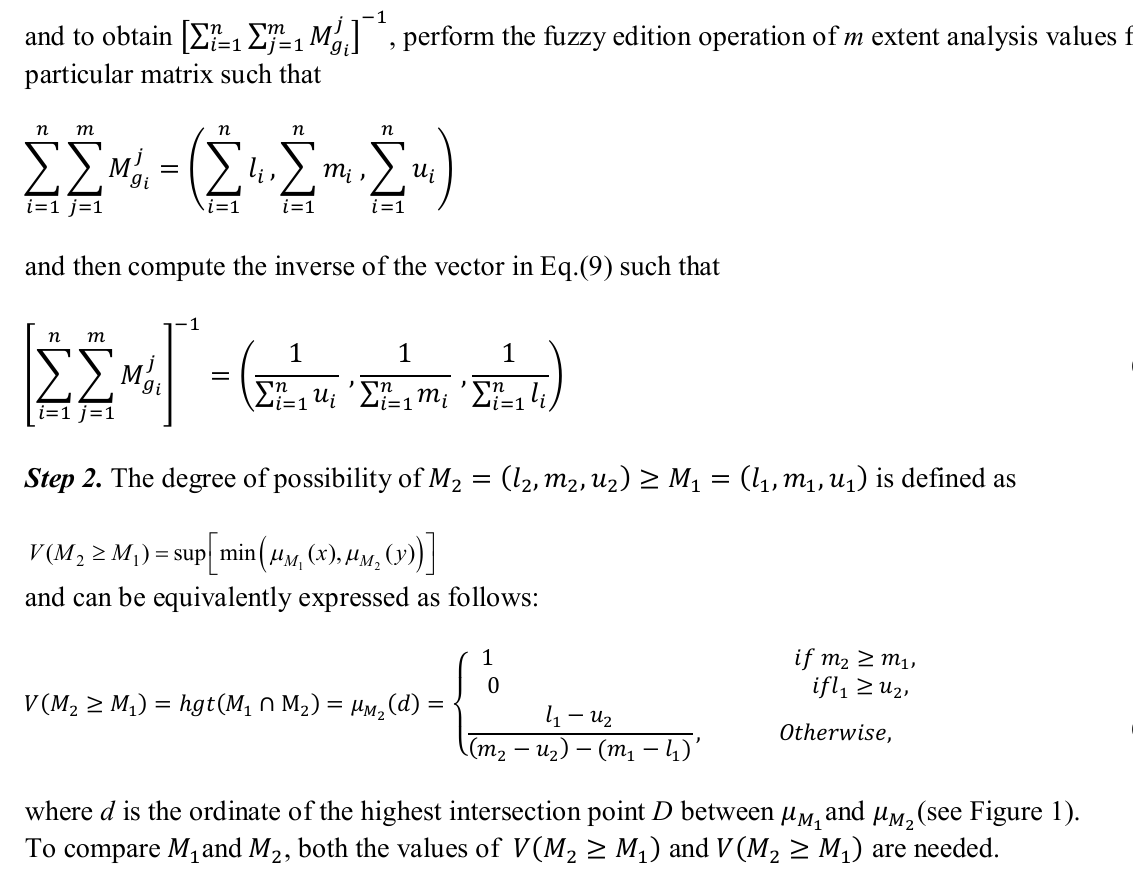
Fig. 1.The intersection between (cid:1839)